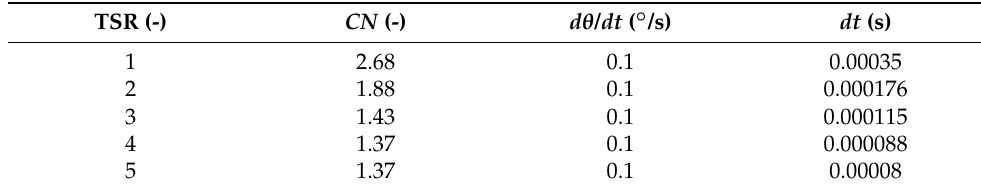
Table 3. Time-step